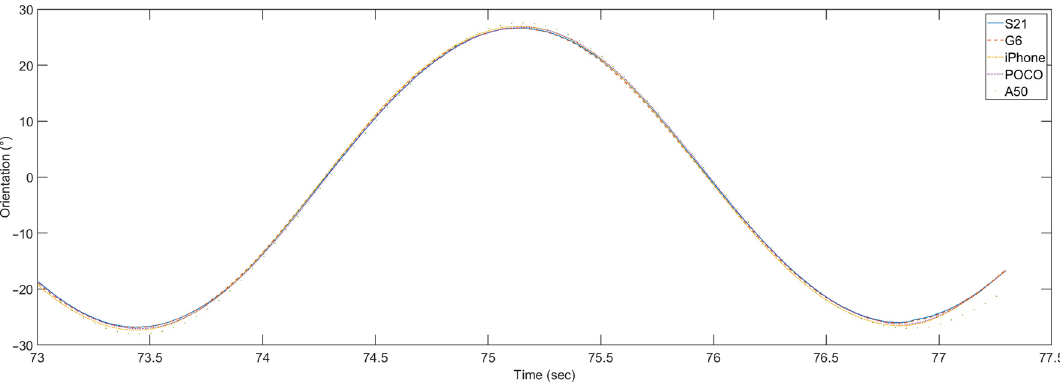
Figure 20. One period of calculated orientation for all five smartphones.